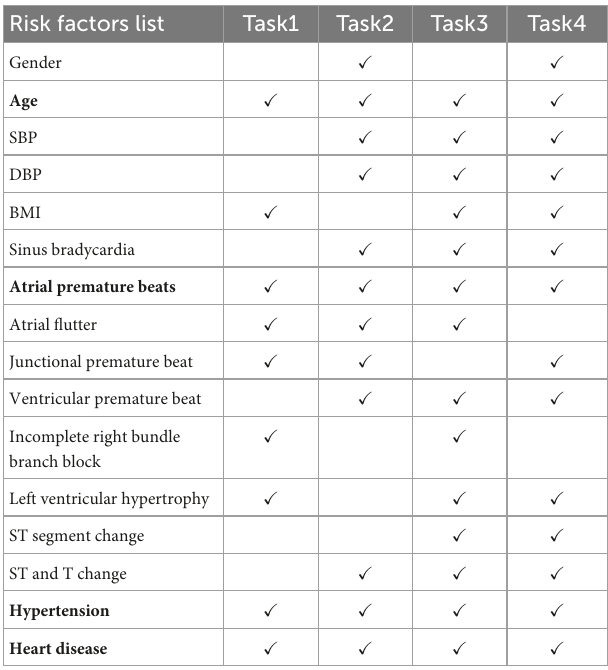
TABLE 9 Important variables in different tasks based on LR models and FS.